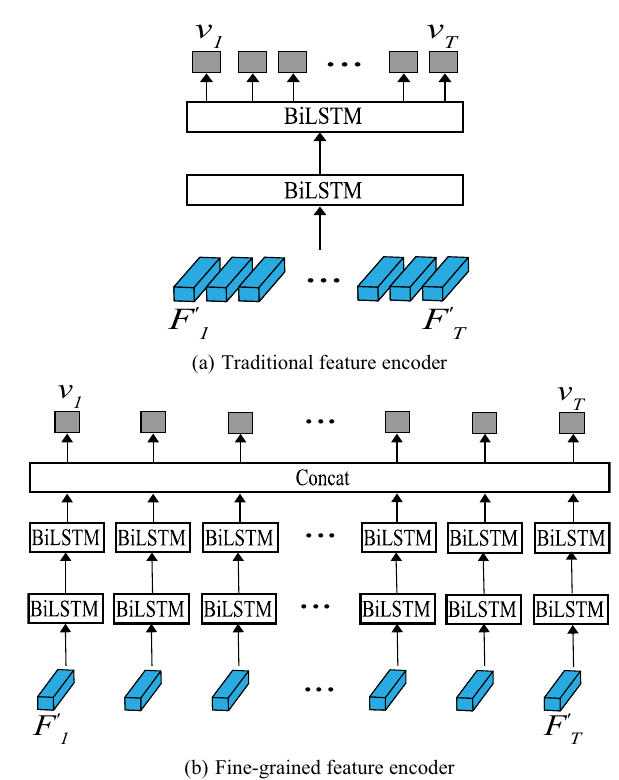
Fig. 6 Overview of encoding